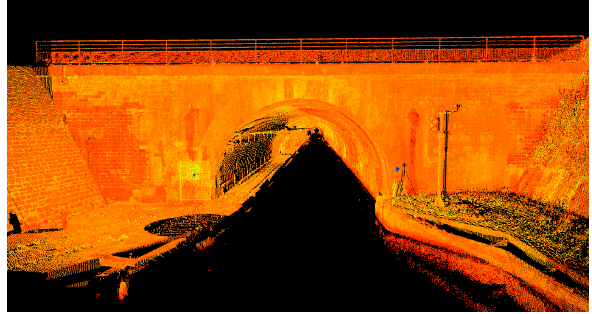
Figure 6: Rendering of the lasergrammetric model at the tunnel exit. No resampling has been applied in this view.